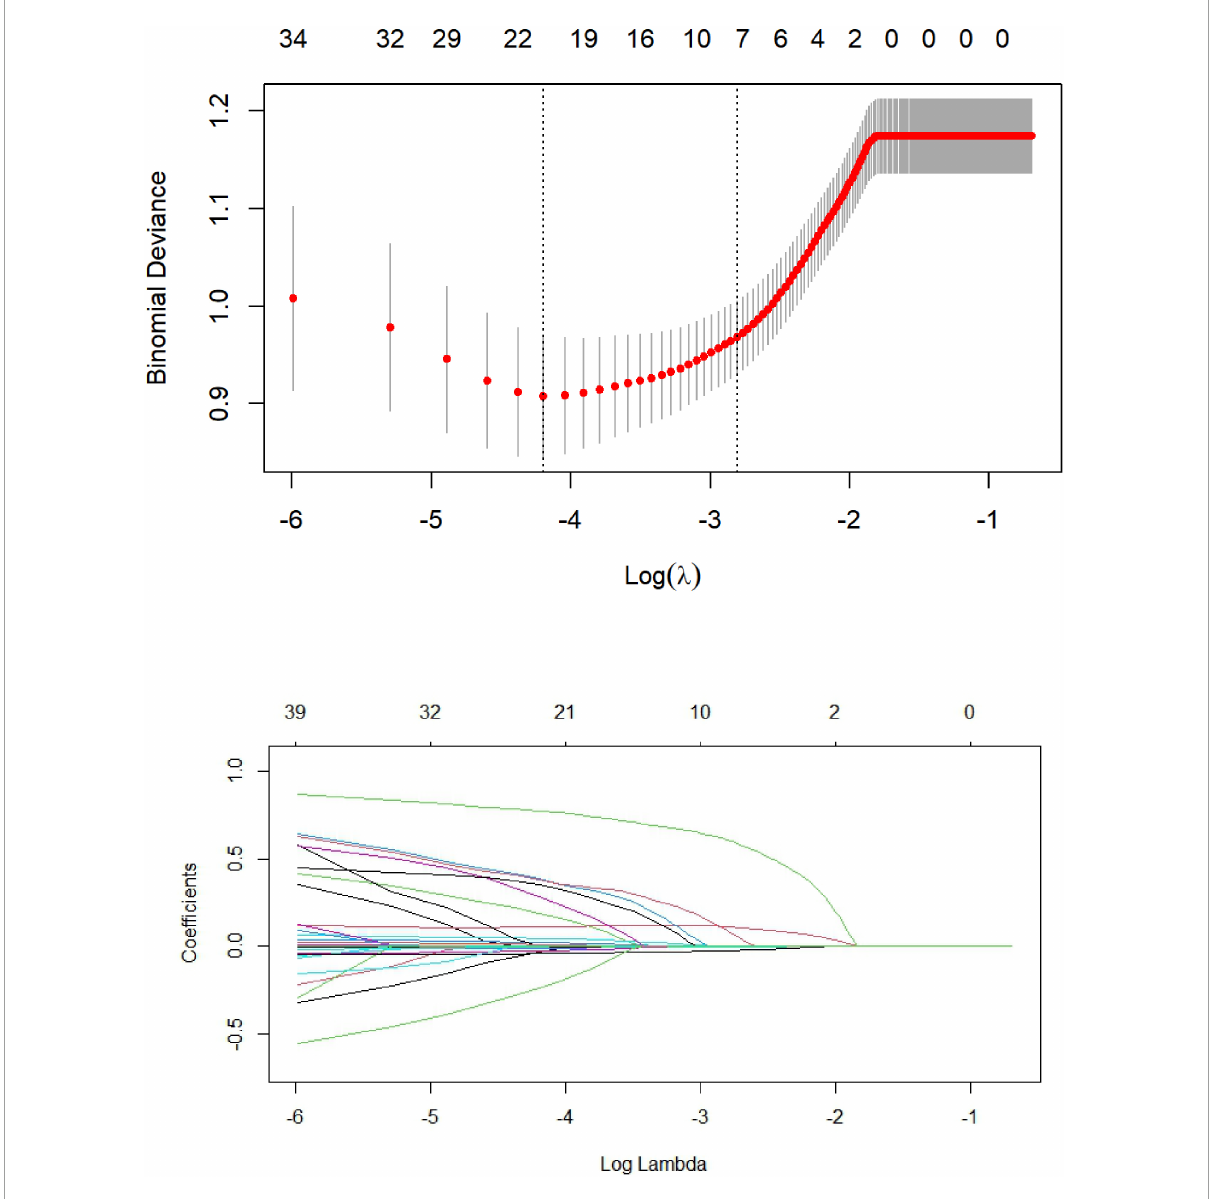
FIGURE1 Predictor plots screened by least absolute shrinkage and selection operator (LASSO) regression analysis.